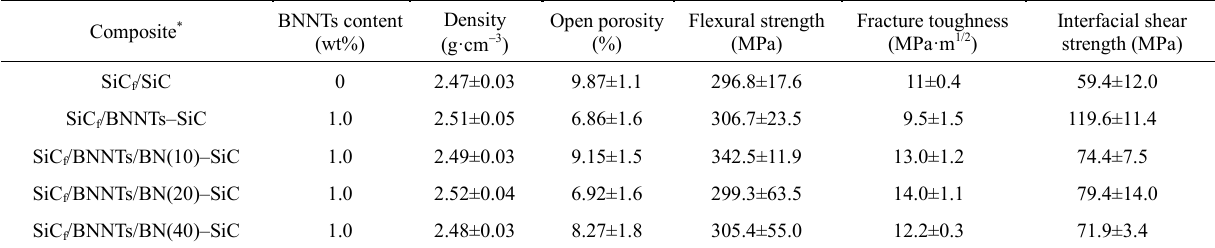
Table 1 Properties of virgin SiC f /SiC composites, as-grown, and BN-coated BNNTs reinforced SiC f /SiC hierarchical composites